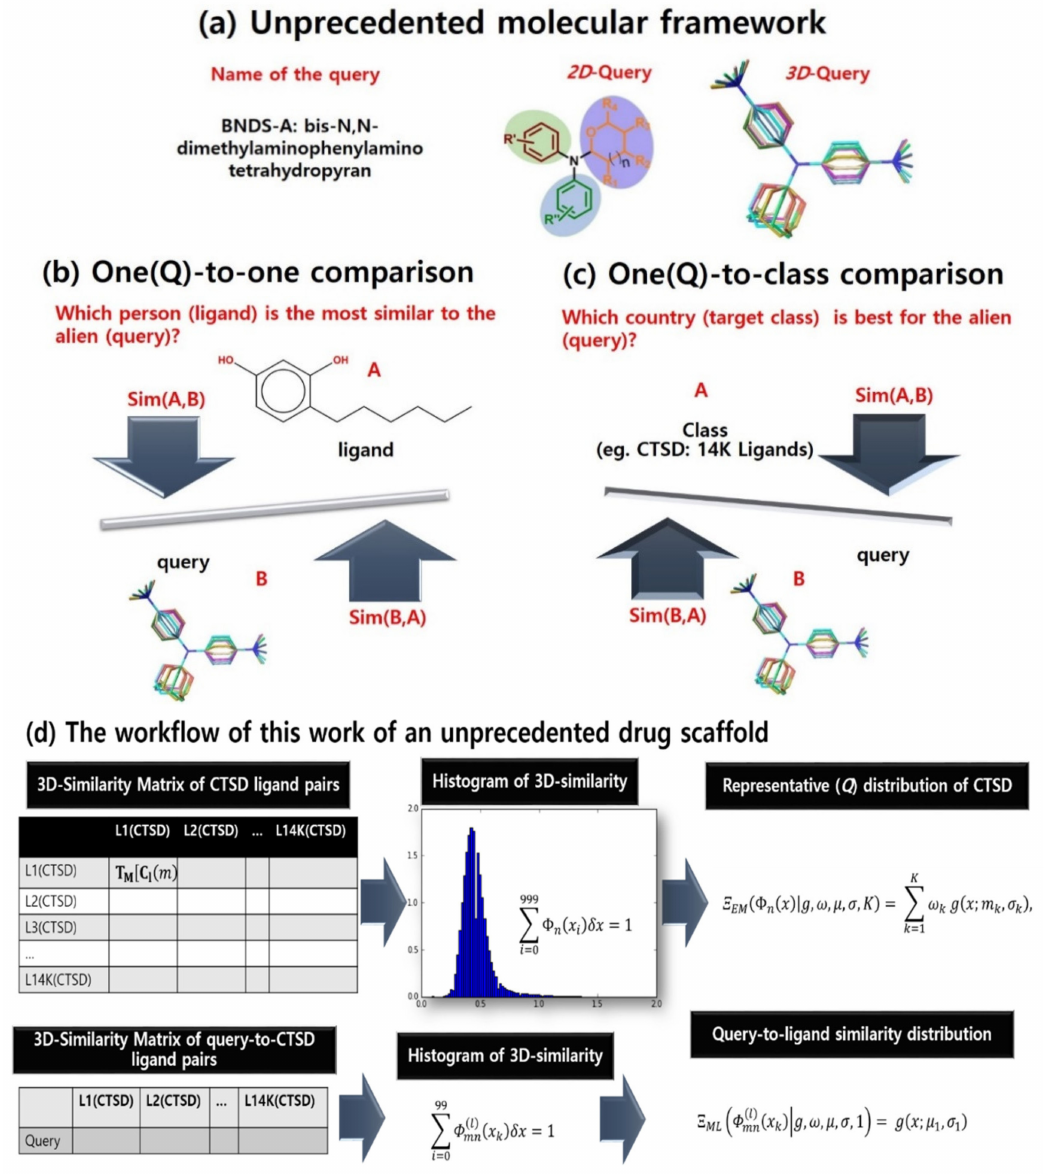
Figure 1. The problem definition of 3D chemo-centric screening. ( a ) BNDS-A as a new molecular framework. ( b ) The role of chemical similarity in virtual screening. ( c ) The role of chemical similarity in chemo-centric retro-virtual screening. ( d ) The workflow of this work of an unprecedented drug sca ff